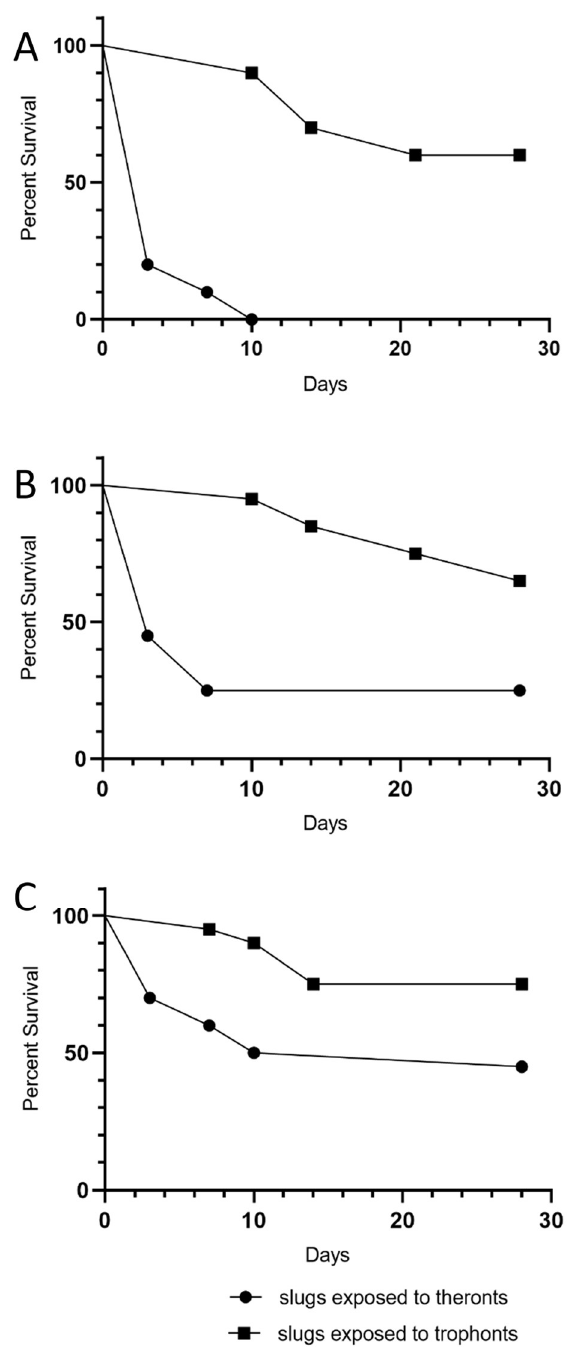
Figure 3. Kaplan-Meier survival plots of Deroceras reticulatum slugs exposed to different doses of T. rostrata theronts and trophonts. Doses were ( A ) 100,000, ( B ) 30,000 and ( C ) 10,000 theronts or trophonts, respectively (20 slugs per treatment).